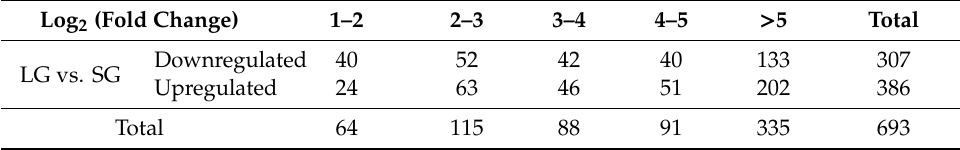
Table 2. Fold-change distribution of DEGs performing Illumina sequencing and de novo assembly for two colonies of Romalea microptera .